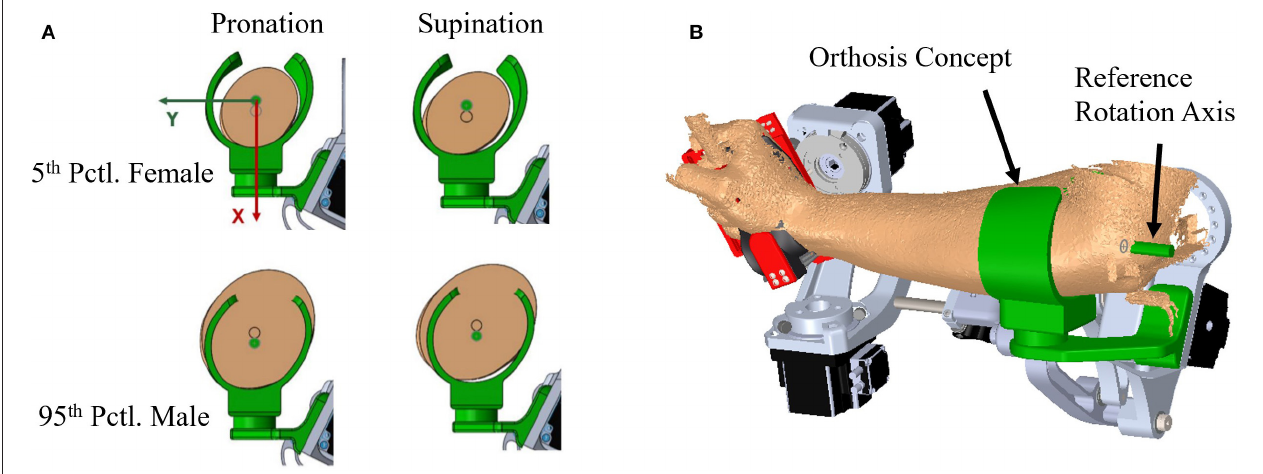
FIGURE 12 | Extrapolated forearm model comparison: (A) Models in pronation and supination for 5th percentile female and 95th percentile male are compared to an orthosis model that has been sized using the proposed method to fit scanned arm data from one of the experimental subjects (B)